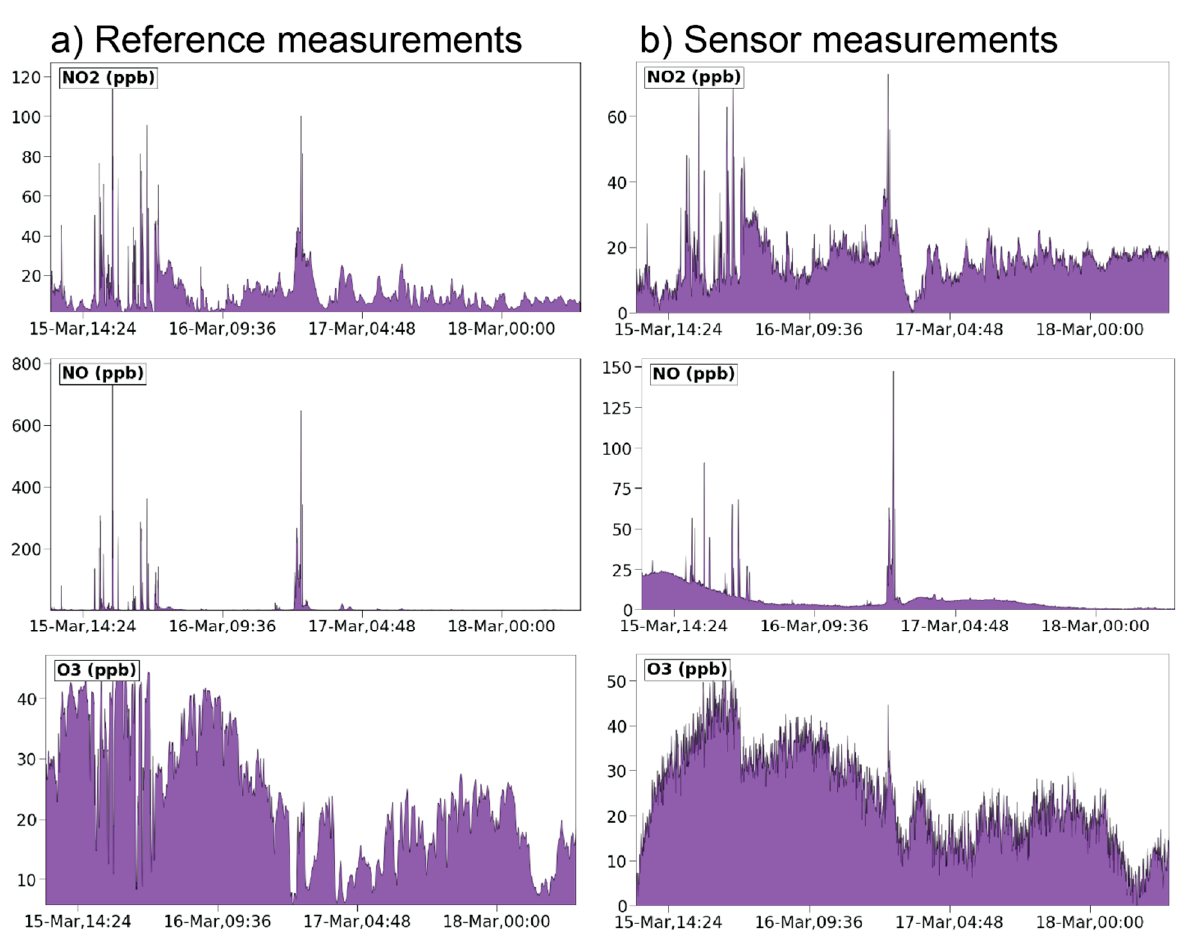
Figure 2. Pollutant concentration over time measured by the reference instrument and the sensor box of the same air in the engine room. The measuring campaign covers the period 15–18 March March 2021. Due to the complexity of the trends, it is impossible to superimpose sensor and reference measurements in a single graph; ( a ) 1-min data collected by the Airpointer containing reference instruments (NO 2 and NO: chemiluminescence as prescribed by EN 14211:2005 [90]; O 3 : ultraviolet photometry as prescribed by EN 14625:2005 [91]); ( b ) 3-min data collected by the sensor box